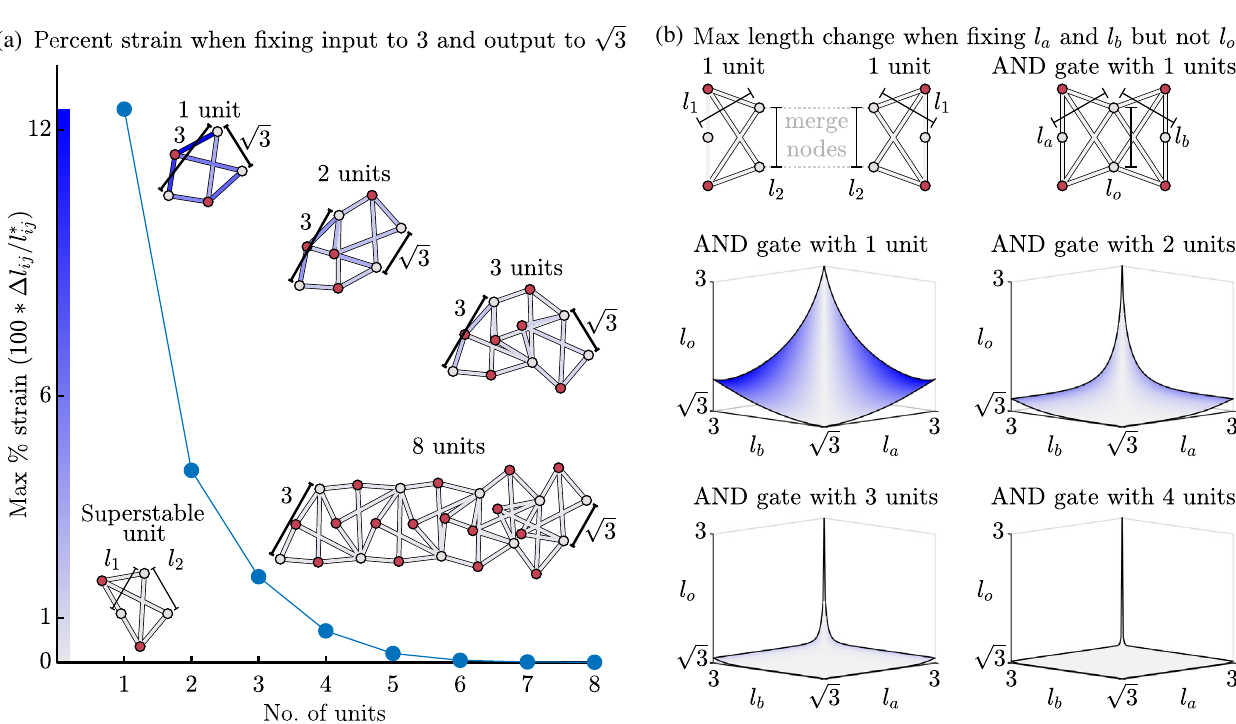
FIG. 15. Elastic deformations in superstable networks. (a) Plot of the maximum percent strain of the elastic bonds in networks comprising k superstable units. The initial length l 1 ¼ 3 is fixed to be open, the final length l k minimum energy configuration is computed for k ¼ f 1 ; 2 ; … ; 8 g . (b) Nodes defining length l k merged to form an AND gate with input lengths l a and l b , and output length l o . For k ¼ f 1 ; 2 ; 3 ; 4 g , the input lengths are fixed at various ffiffiffi p 3 ≤ l ; l ≤ 3 , and are plotted against the output length l values between a b